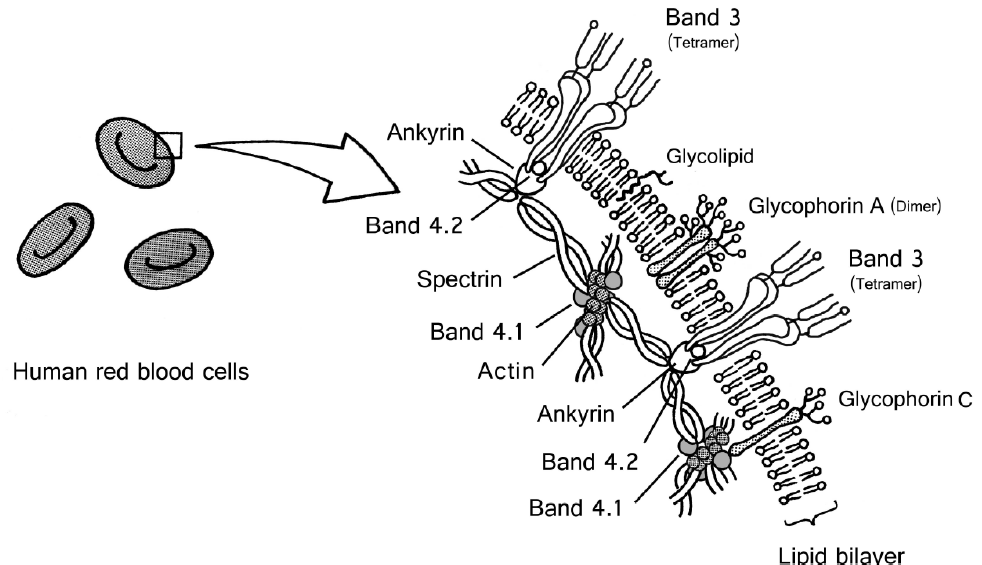
Figure 3. Illustration showing the location of band 3 and glycophorins in human red blood cell membranes. This illustration is based on several reviews [14,15,22]. According to Lux [14], the location of substoichiometric proteins (e.g., CD44, CD47, Lu, Kell, Duffy) remains unclear. In this illustration, these glycoproteins are omitted, the actin junctional complex (4.1R complex) is simplified, and the topology of band 3 and glycophorins is defined.